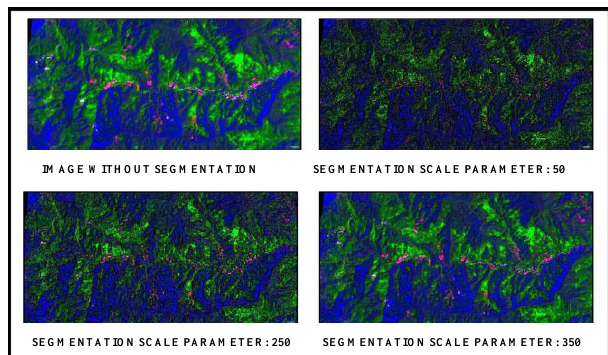
Figure 7. Segmentation test for Gobia analysis.